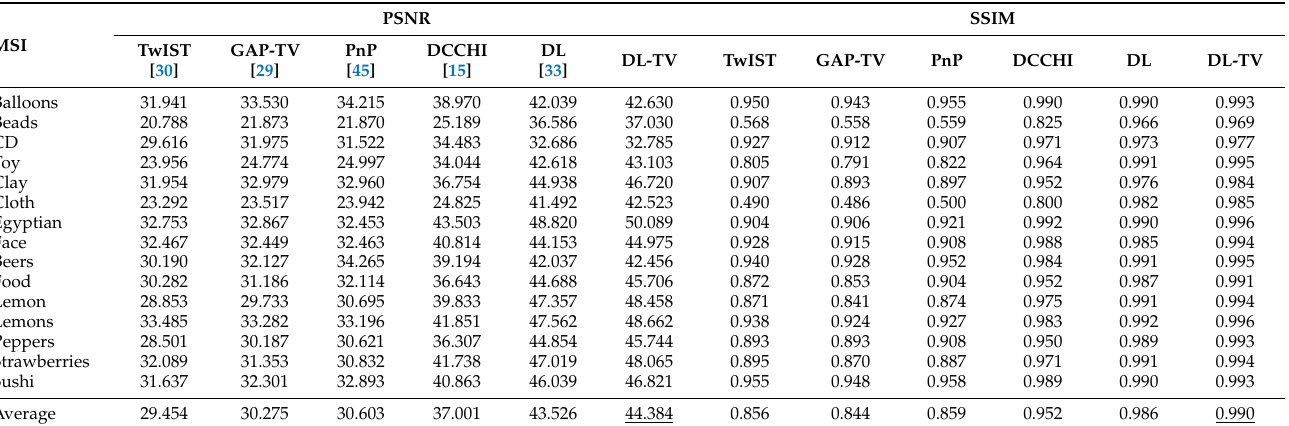
Table 1. Average peak signal-to-noise ratio (PSNR) and structural similarity index measure (SSIM) of the 15 reconstructed MSIs corresponding to the CAVE